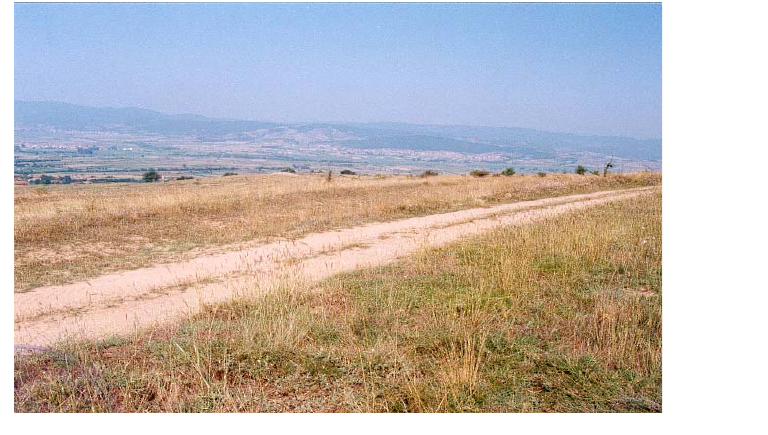
Figure 5 – Location 3 "Bratoselce" Рисунок 5 – Локация 3 « Братоселце »